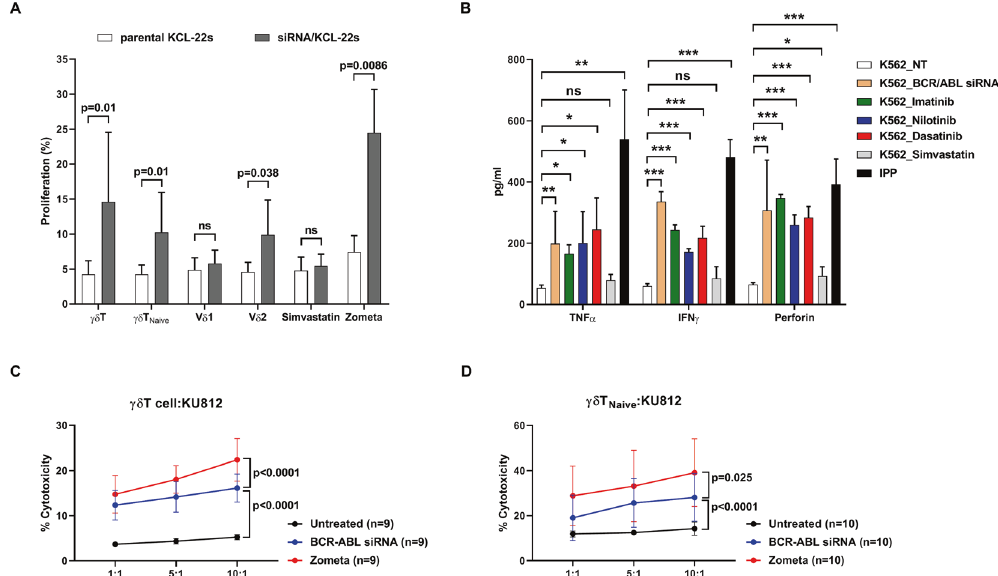
Fig. 3 Expansion and activation of γδ T and its subsets when co-cultured with CML cells treated with BCR-ABL inhibitors. A Expression of isolated γδ T cells was determined by CFSE-labeling. CFSE-labeled γδ T cells were co-cultured with BCR-AB L-knockdown KCL22 cells (black bar) or untreated KCL22 cells (open bar). Simvastatin-pretreated, zoledronate-pretreated, or BCR-AB L siRNA-pretreated KCL22 cells were used as the targets for γδ T cells at a ratio of 1:1. Zoledronate (Zometa, 5 μ M) but not simvastatin (100 nM) rendered KCL22 cell proliferation. B Expression of TNF- α , IFN- γ , and perforin release of isolated γδ T cells from six healthy donors was determined by ELISA after co-culture with BCR-ABL siRNA-, TKI-, simvastatin-treated, or untreated K562 cells for 24 h. Treatment with IPP (0.5 μ M) was used as a control to activate γδ T cells. The ex-vivo killing assays were performed using isolated ( C ) γδ T cells and ( D ) naïve γδ T cells isolated from healthy donors. The targets could be untreated KU812 cells, or KU812 pretreated with BCR-ABL -speci fi c siRNA or zoledronate. The incubation time for target- γδ T cells and for target- naïve subset was 4 h and 24 h, respectively. One-way ANOVA was used for comparison between multiple groups, and paired t test was used to compare selected groups. Statistical signi fi cances between these groups are marked with asterisk. Data were presented as mean values ± SD. Data comparison was performed by the paired t test. Statistical signi fi cance was de fi ned by * p < 0.05, ** p < 0.01, and *** p <